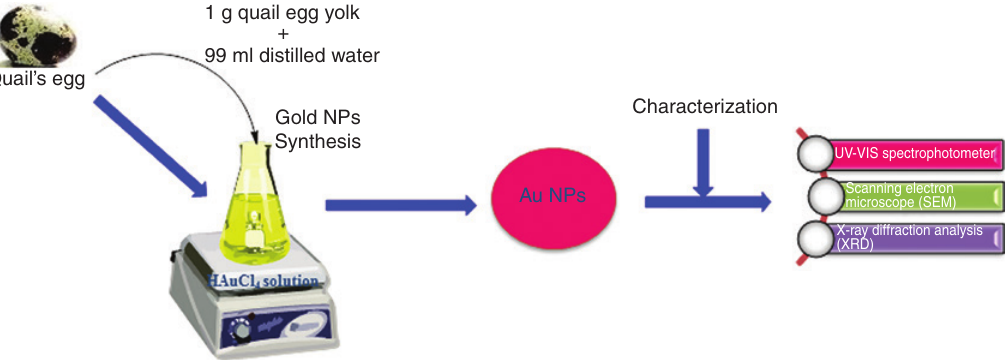
Figure 1: The processing to prepare the reaction medium.